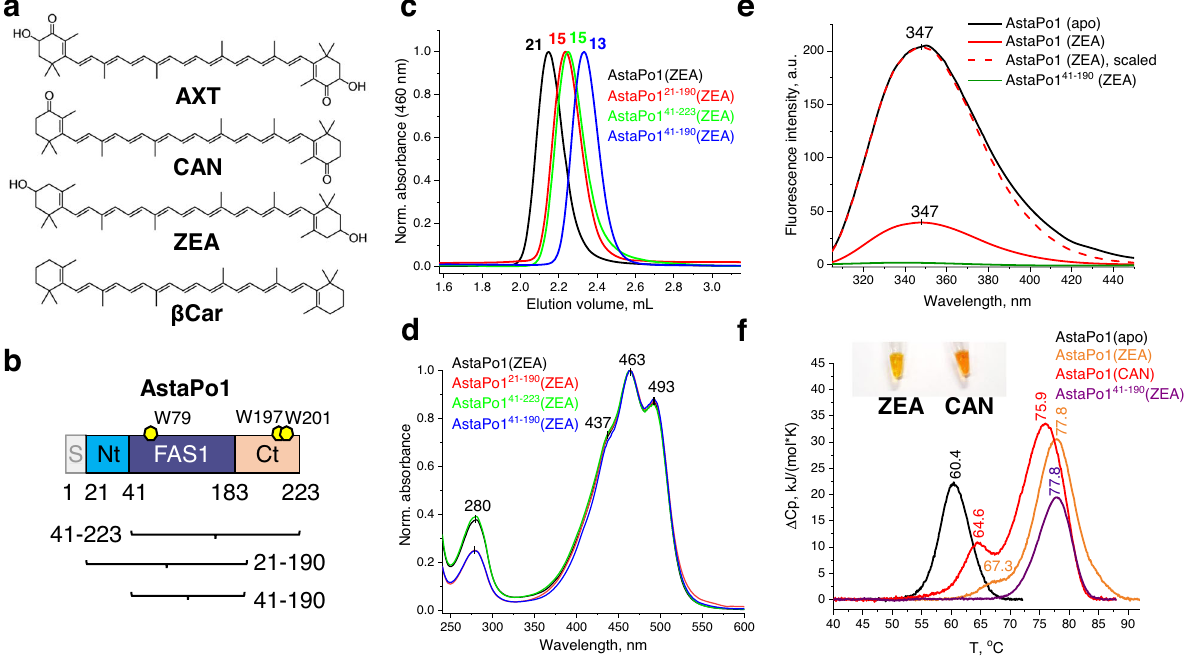
Fig. 1 Localization of the carotenoid-binding region of AstaPo1. a Structural formulae of several carotenoids which can be bound by AstaPo1. AXT astaxanthin, CAN canthaxanthin, ZEA zeaxanthin, β Car β -carotene. b The domain structure of AstaPo1 showing the location of the predicted FAS1-like domain and the fl anking N- and C-terminal regions. Note that the AstaPo1 preprotein contains an N-terminal signal peptide (residues 1 – 20), which was omitted in our construct as this peptide hampers the expression and puri fi cation of the soluble protein. Instead, the N terminus of the protein carried arti fi cial residues 17 GPHM 20 left after the His 6 -tag removal. c , d Analytical SEC pro fi les with diode-array detection, revealing the effect of AstaPo1 truncations on the size of the protein monomer ( c ) and its absorbance spectrum ( d ). The apparent M w values determined from column calibration are indicated in kDa. e Intrinsic Trp fl uorescence spectra of AstaPo1 showing the effect of ZEA binding to the wild-type and truncated AstaPo1. The excitation wavelength was 297 nm. f DSC thermograms showing the effect of carotenoid binding and truncation of the N- and C-terminal regions on the thermal stability of AstaPo1. T m values are indicated as determined from the maxima of the peaks. The heating rate was 1 °C per min. The insert shows the color of the AstaPo1 samples with ZEA or CAN